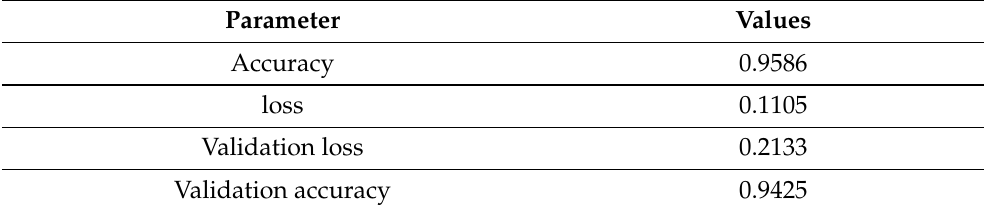
Table 2. Result Analysis of